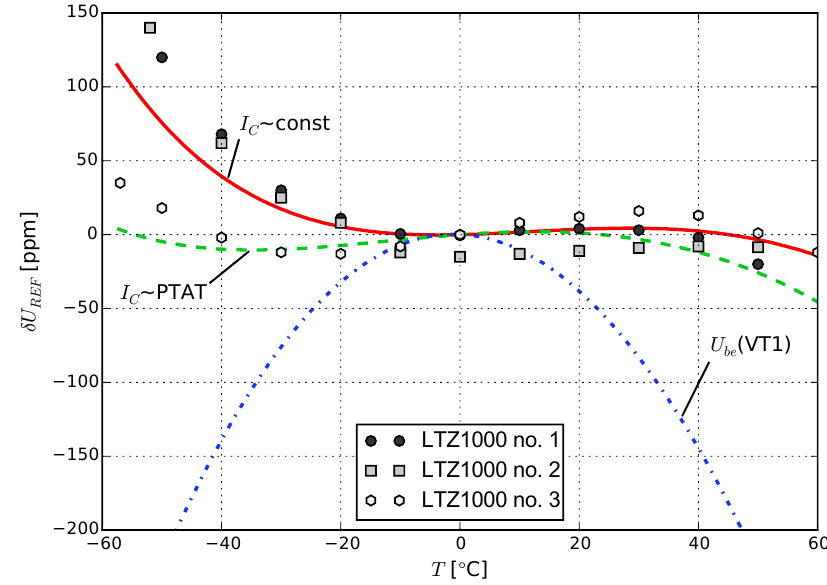
Figure 3. Temperature dependence of LTZ1000 reference voltage – simulated results (lines) and experimental data (marks). Table 2. Noise level of some precision voltage